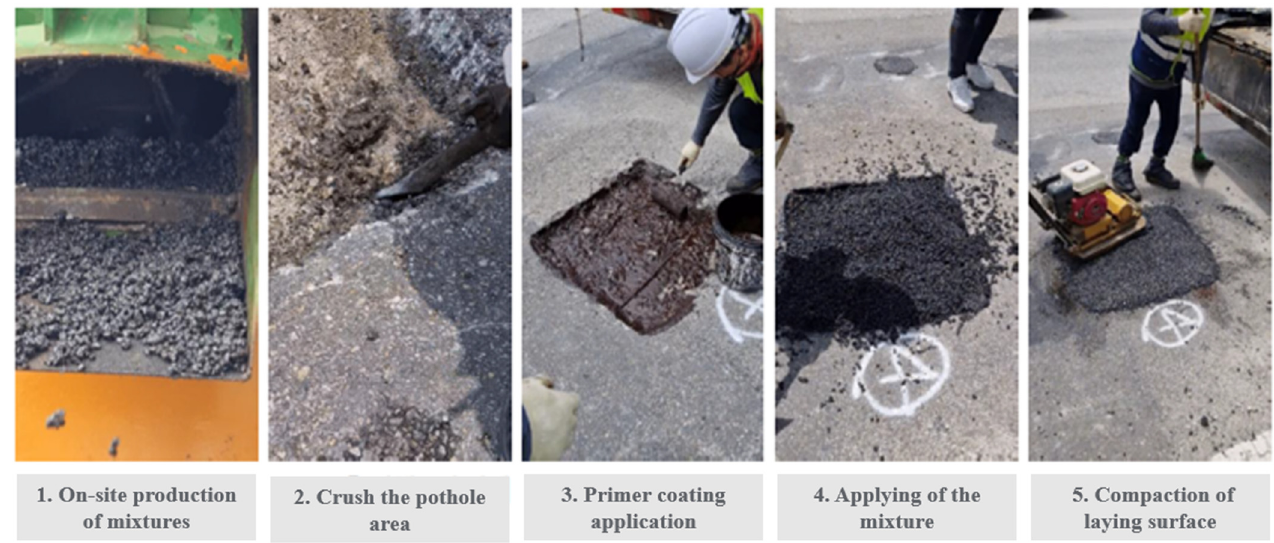
Figure 7. Step-by-step construction process.